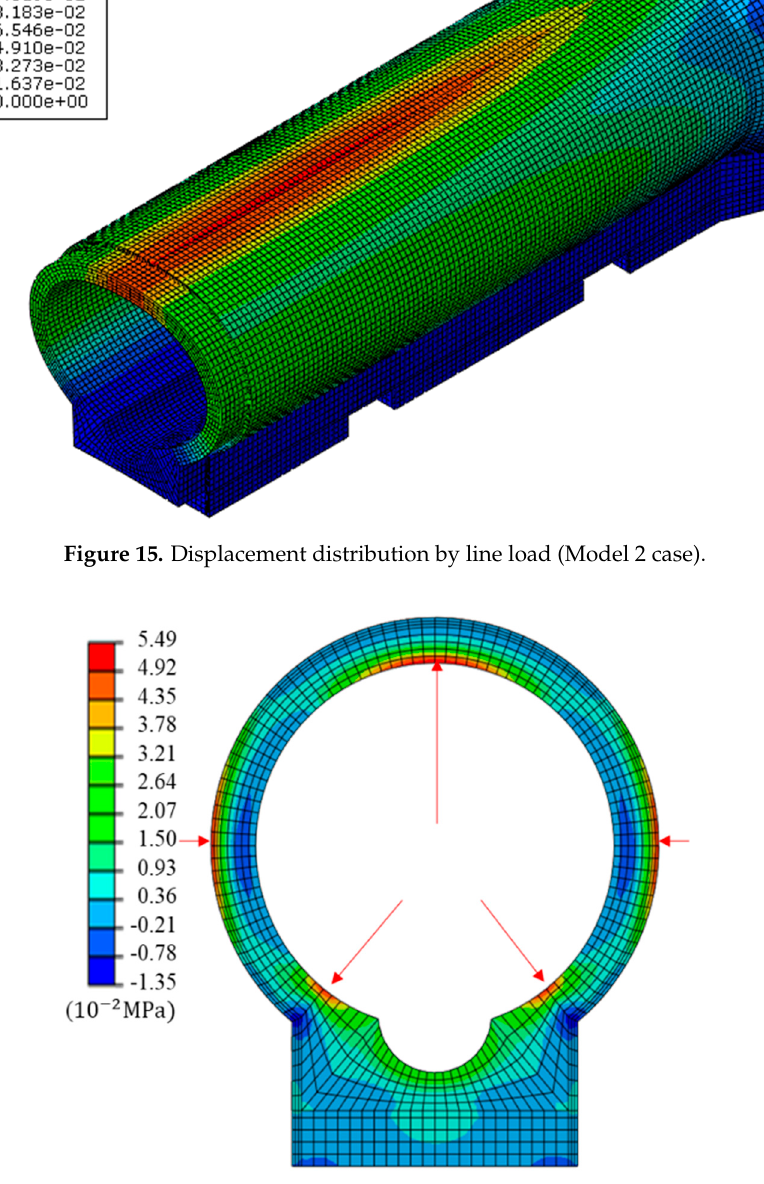
Figure 16. Tensile stress distribution by modeling under only concrete pipe weight.